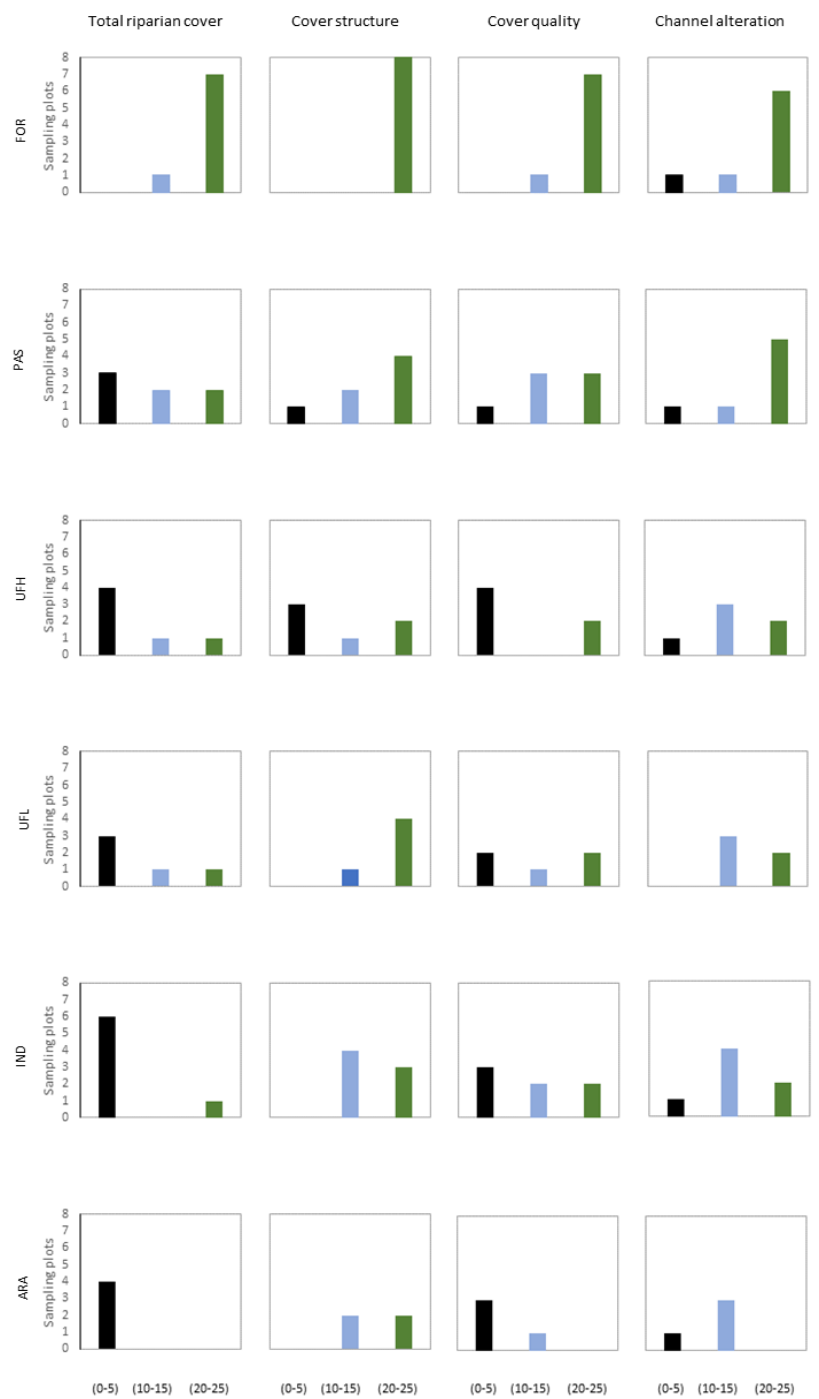
Figure 6. Graphs of the four separated sections of QBR and their grouped scores in relation to land-use classes, e.g., in graph IND/section cover quality, three sampling plots received scores 0 – 5, two 10 – 15, and two 20 – 25.